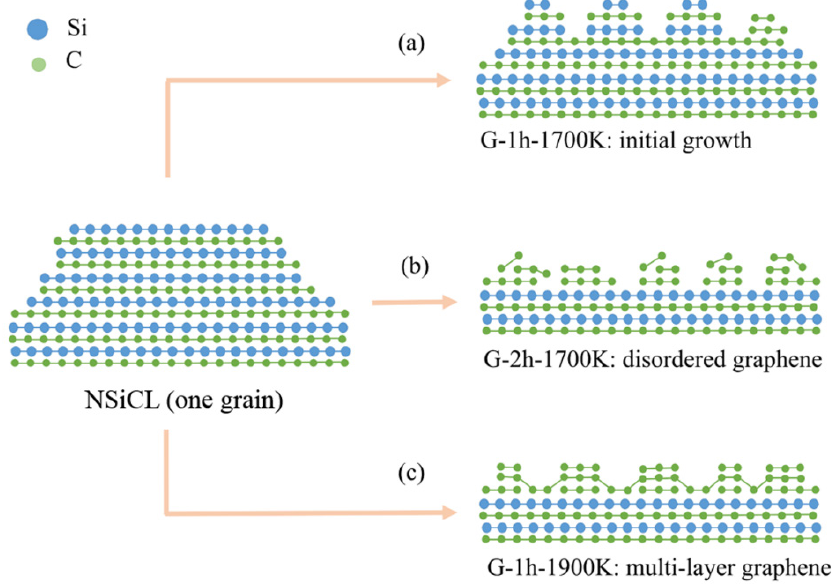
Figure 5. Schematic illustration for surface evolution of NSiCL (one grain extracted from the nano-textured SiC layer as an example) and corresponding graphene growth. After subjection to high temperature treatments (HTTs), nano-patterns on the SiC layer were reduced. Here, ( a ) G-1h-1700K; ( b ) G-2h-1700K; and ( c ) G-1h-1900K are, respectively, instances of initial growth, disordered graphene growth, and multi-layer graphene growth according to various treatment